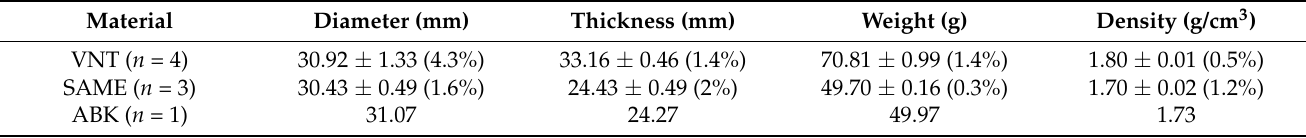
Table 2. Main physical characteristics of tested Qvevri samples from different regions in Georgia.